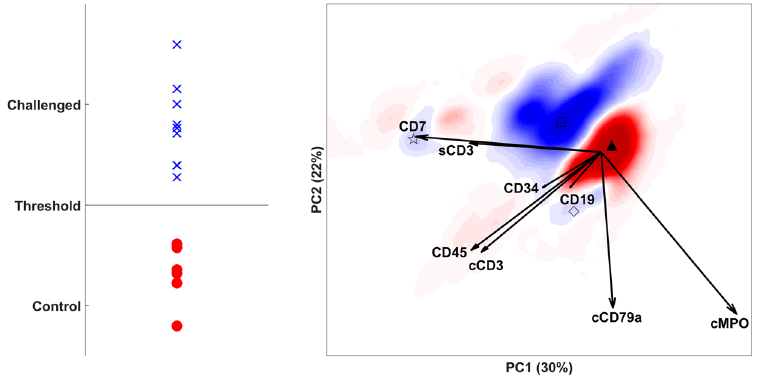
Figure 4. DAMACY model of AML data. The left panel shows the average prediction score of controls (red rounds) and AML patients (blue crosses). The right panel shows negative weights as red and positive weights as blue. The loadings of the Base model are plotted on top as black vectors and indicate how each marker contributes to the cell variability in a specific direction.